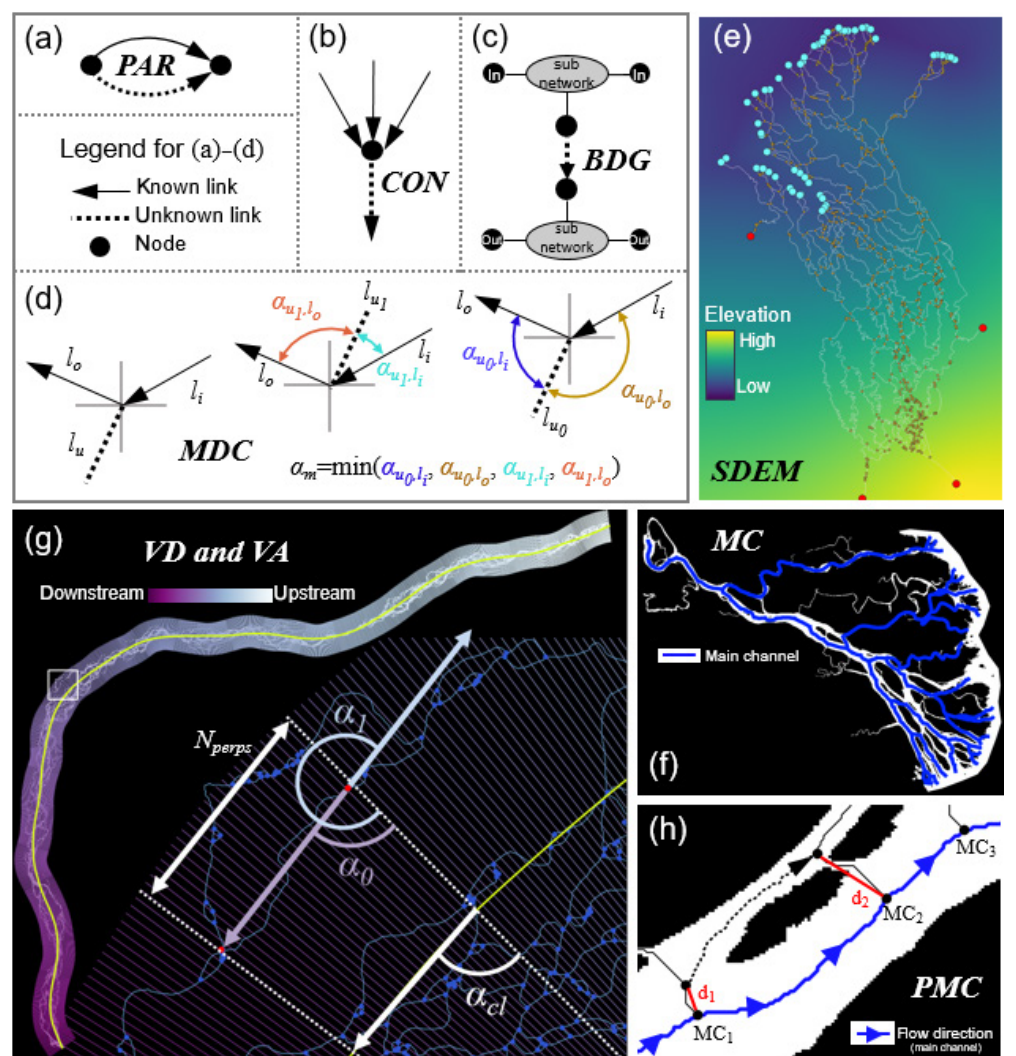
Figure 2. Diagrams showing the direction-predicting algorithms (DPAs). Symbology is further explained in Sect. 3.1. (a) Predicting an unknown parallel link. (b) An example of applying CON to determine the unknown link. (c) Predicting a bridge link with BDG. (d) Using the minimum direction change MDC for predicting the unknown link. (e) A synthetic DEM (SDEM) for the Mackenzie Delta is shown with blue outlets and red inlets. (f) A centerline mesh is shown for the Brahmaputra River with a yellow centerline to demonstrate VD and VA. The box denotes the bounds of the zoom view. The unknown link’s endpoints are marked by red points. Dashed lines follow the mesh perpen- diculars. (g) Main channels found by MC for the Colville Delta are denoted by blue lines. (h) An example of main channel parallels (PMC). Distances d 1 and d 2 are defined in Sect. 3.1; MC n refers to the n th main channel node, ordered from upstream to downstream. The dashed link’s flow direction is initially